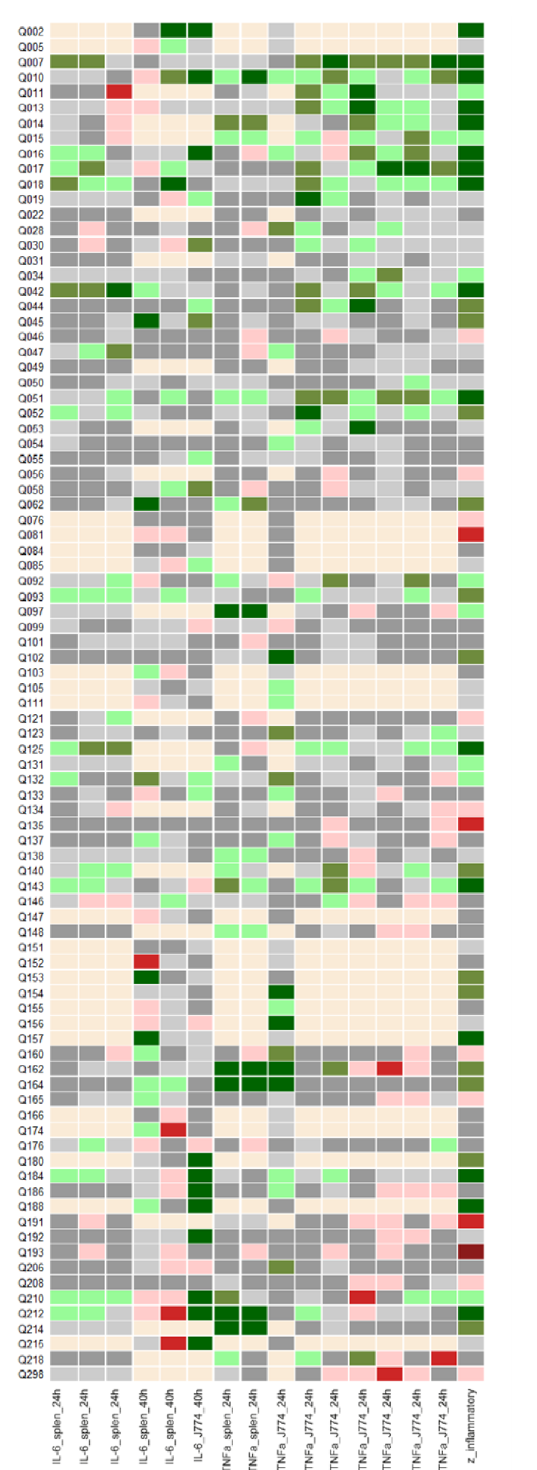
Figure 1. Heat plot of inflammatory screening on splenocytes and J774 cells. The y -axis represents all QSPs, while the x -axis represents the different experiments and the global inflammatory z-score (rightmost column). Each experiment is named based on its measured cytokine (IL-6 or TNF α ), used cell type (spleen or J774) and incubation time (24 or 40 h). QSP concentration is 100 nM for all experiments. The colours are based on the z-score for each QSP in a specific experiment or overall for the column “z_inflammatory”. Missing data are indicated in faint